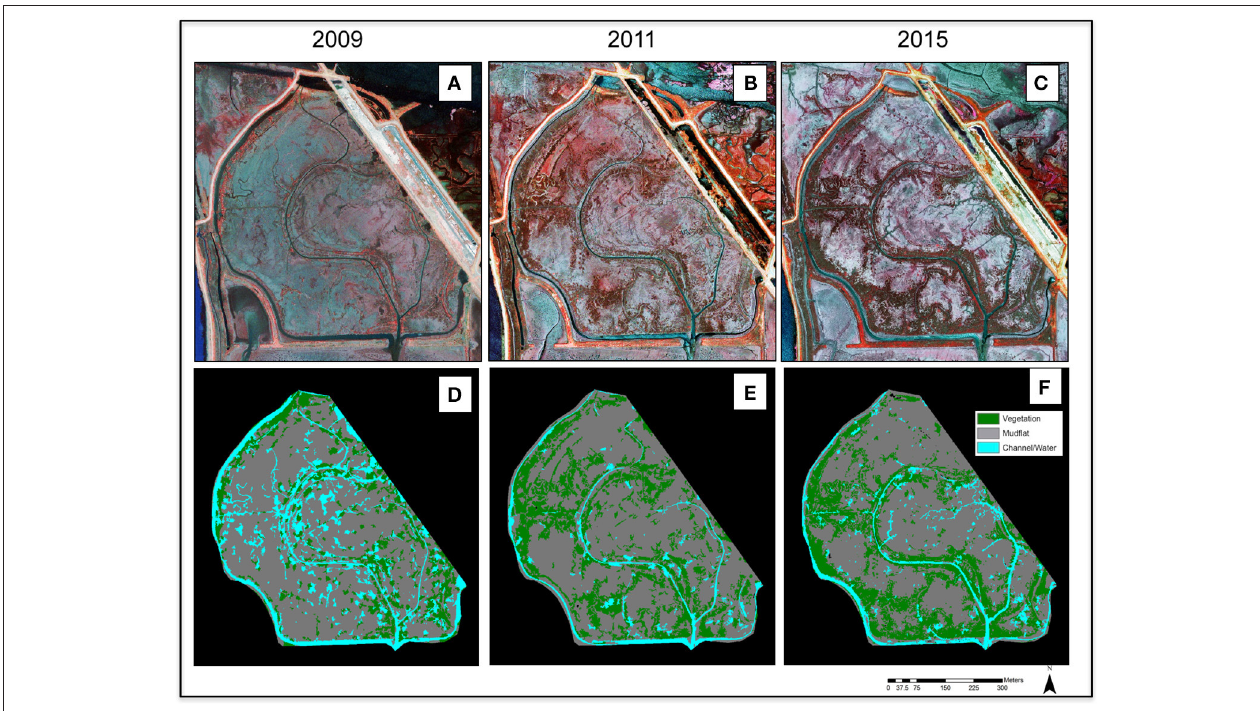
FIGURE 4 | Change over time at North Creek Marsh. (A–C) False color imagery for 2009, 2011, and 2015. (D–F) Classifications of cover types for 2009, 2011, and 2015. Aerial images reproduced with permission from © DigitalGlobe,